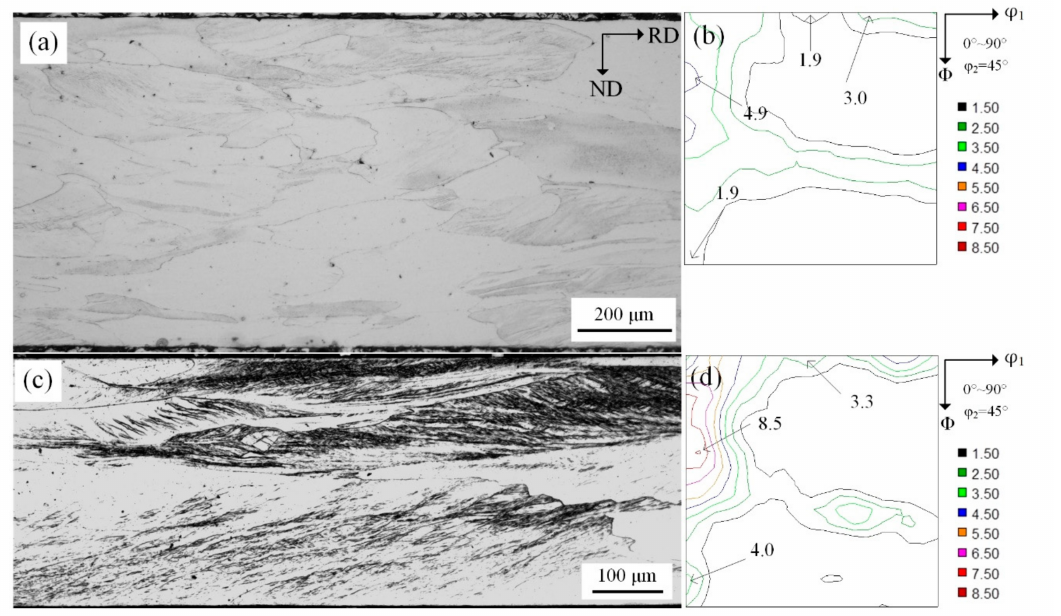
Figure 3. Microstructure of 50% ( a ) and 77% ( c ) reduction and constant ϕ 2 = 45 ◦ sections of ODFs at subsurface layer (S = 7/8) of 0.75 mm ( b ) and 0.35 mm ( d ) cold-rolled sheets